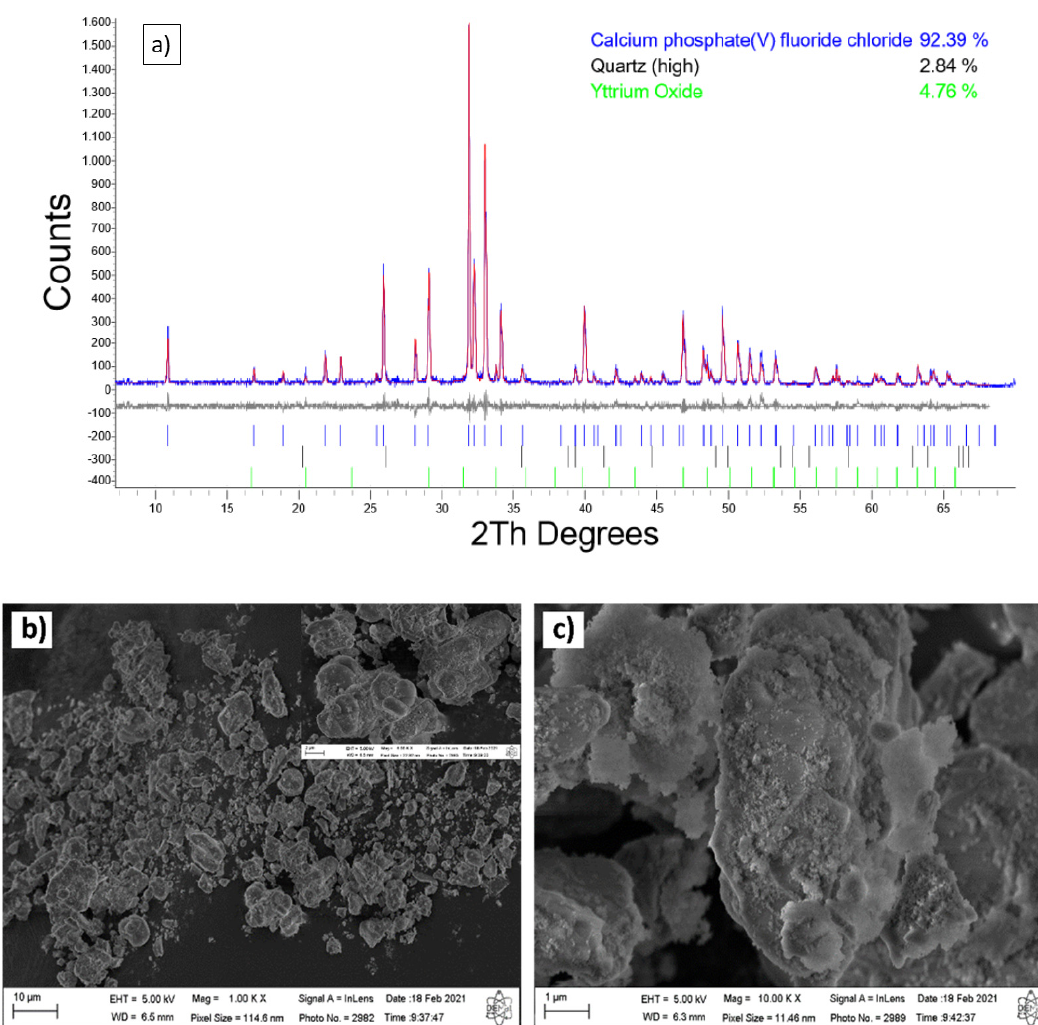
Figure 1. ( a ) XRD patterns of the fluorescent lamp, Rietveld refinement plot for phosphor powder, the vertical lines provide the positions of all possible Bragg reflections for the calcium phosphate (V) fluoride chloride phases (database_code-ICSD 203026), quartz (high) (database code_ICSD 89287), and yttrium oxide (database_code_ICSD 66730). The values of the standard agreement indices are Rp—12.15, Rwp—16.11, Rexp—13.74, Gof—1.17; ( b , c ) SEM images of the phosphor powder. Table 2. Chemical composition from the residue of the fluorescent lamp.